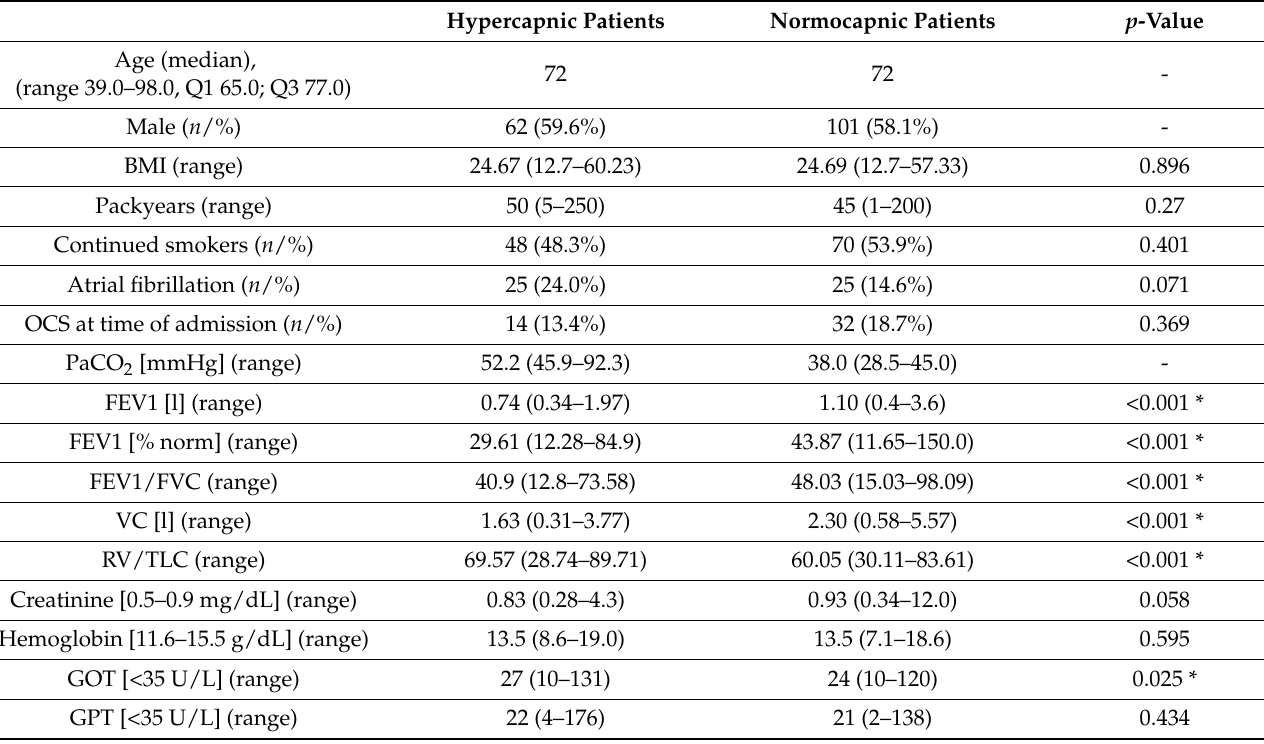
Table 1. Baseline characteristics and laboratory results.